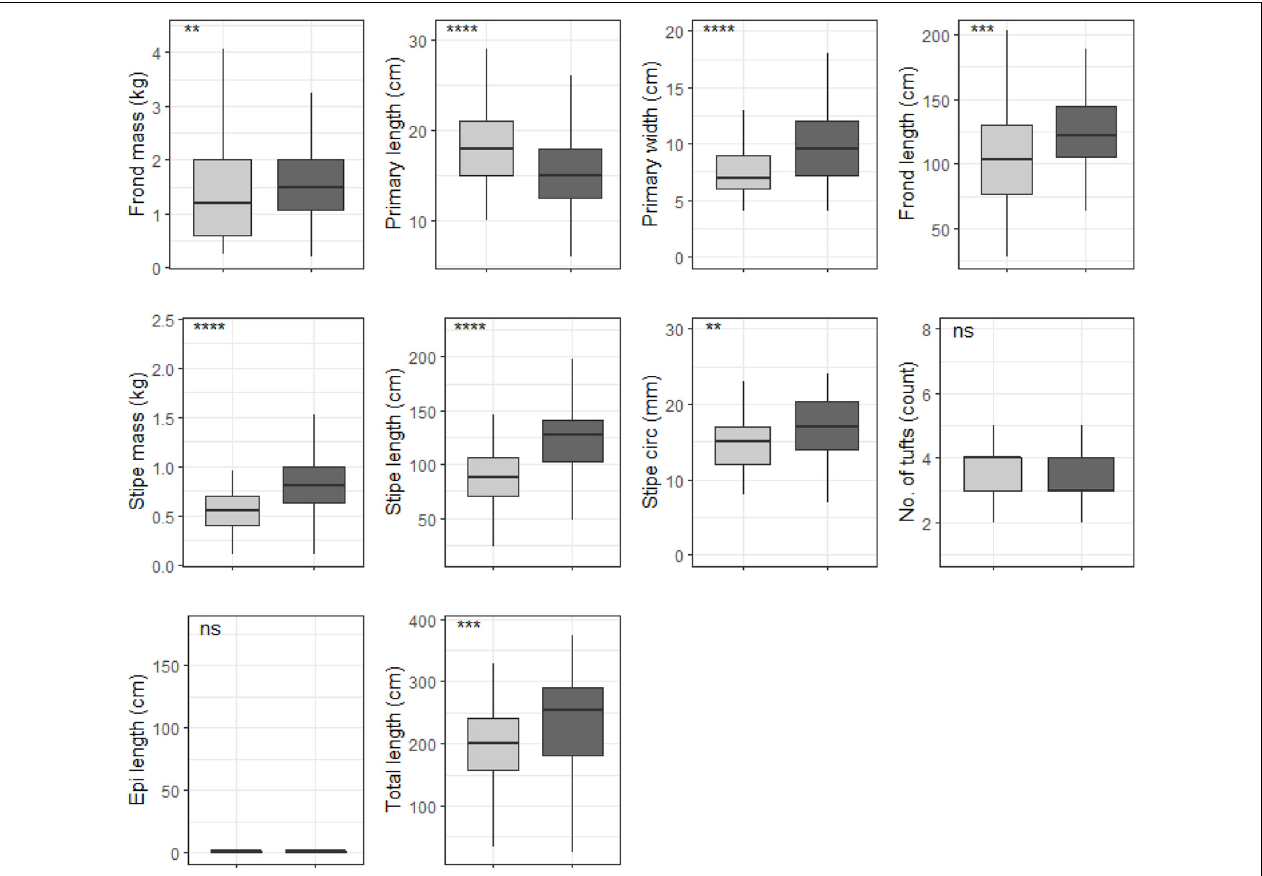
FIGURE 10 | Boxplots representing shallow E. maxima morphological characteristics grouped by temperature regime measured around the Western Cape coastline, with the y -axis depicting the specific morphology measured, with units provided. The lower and upper hinges correspond to the first and third quartiles. The whiskers represent the range, solid black lines represent the median and black dots are outliers. Light gray boxes represent cool-temperate and dark gray warm-temperate. Significance levels are as follows: * represents ≤ 0.05, ** represents ≤ 0.01, *** represents ≤ 0.001, **** represents ≤